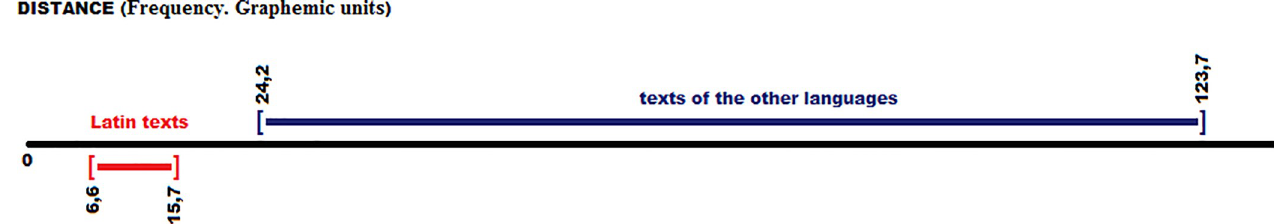
Fig 3. Distances between the Latin (average value) with all the texts in all the languages (graphemic